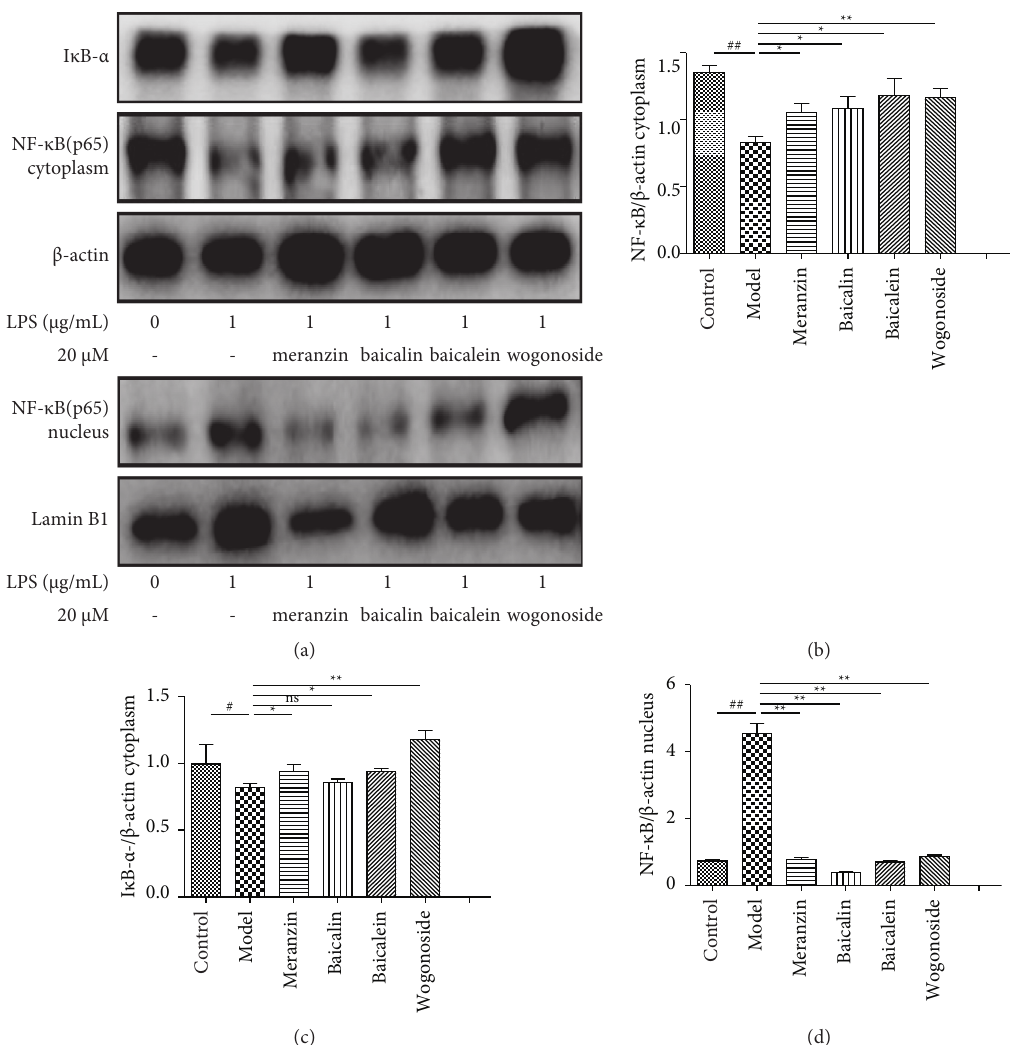
Figure 10: Effects of meranzin, baicalin, baicalein, and wogonoside on the nuclear translocation of NF- κ B in the lipopolysaccharide- stimulated RAW264.7 cells. The model group was treated with the basal medium for 2h and then stimulated with 1 µ g/mL LPS for 24h. Results are expressed as mean ± SD from three independent experiments ( n �